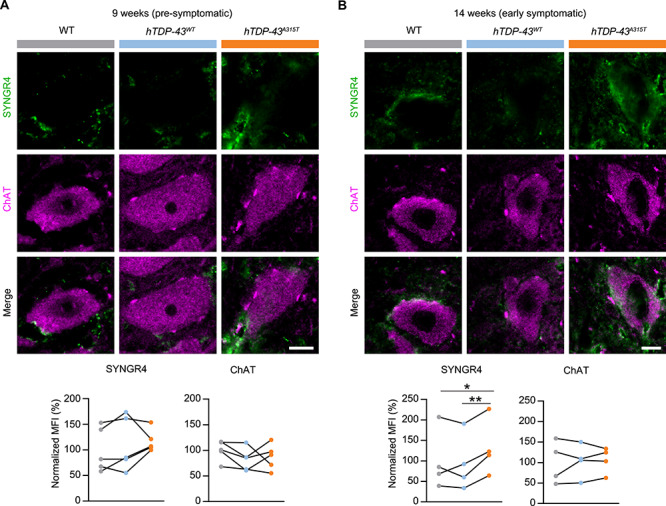
Increased SYNGR4 protein levels in spinal cord MNs of hTDP-43A315T ALS mice after disease onset. Immunofluorescent confocal images of SYNGR4 and ChAT co-staining of spinal cord MNs from L3–5 of hTDP-43A315T (A315T), WT and asymptomatic hTDP-43WT control (hTDP-43). Representative images are shown for 9-week-old (A) and 14-week-old (B) mice with quantification of mean fluorescent intensity (MFI). n = 4–5; values for each genotype from each specific experiment are shown; corresponding genotype pairs from a specific replicate are linked by black lines; paired t-test; scale bar: 10 μm.